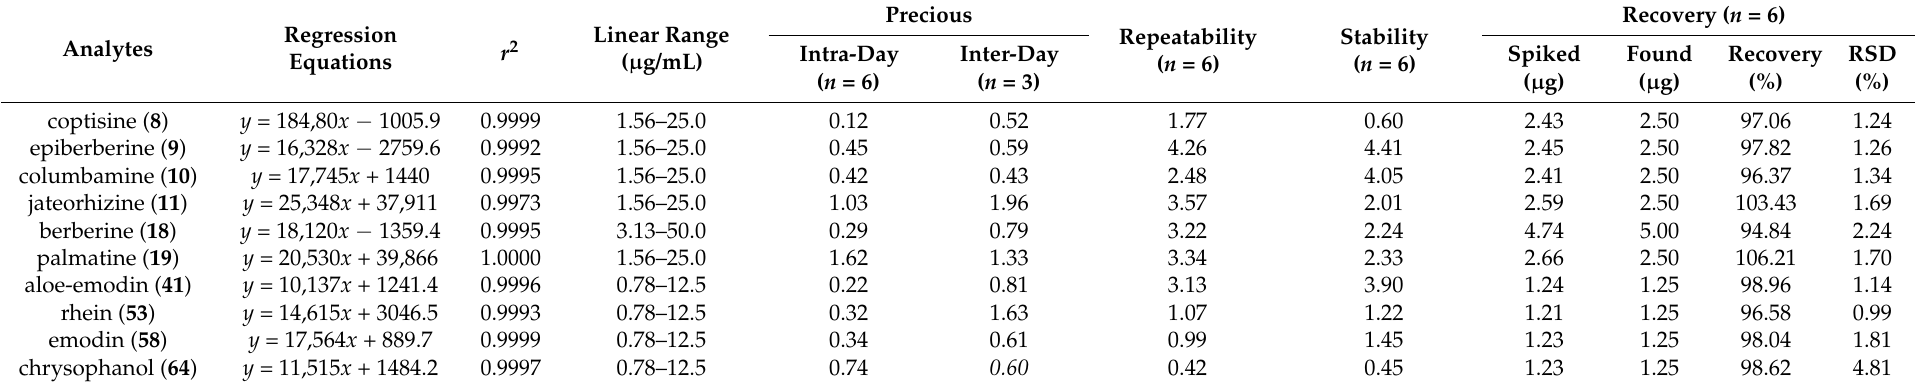
Table 2. Method validation results for quantitative analysis of 10 compounds in GDL